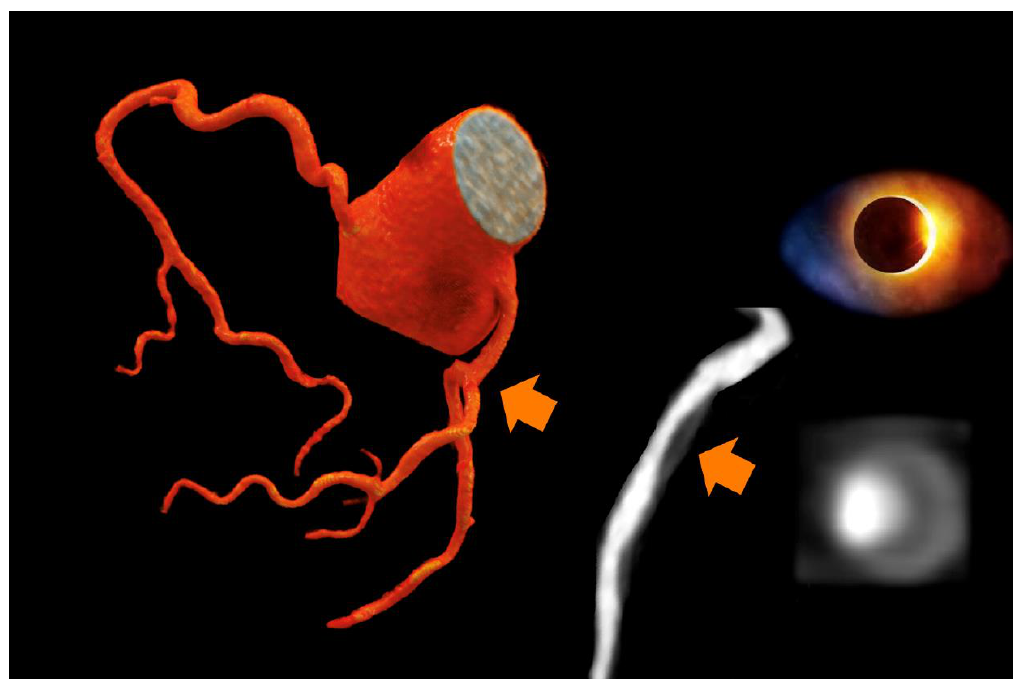
High-risk plaques by CTA were less frequently found in the vitamin D group as compared to controls ( p = 0.012). The high-risk plaque criteria spotty calcification and napkin ring sign were found slightly more often in controls, but prevalence was very low. Figure 2 shows a patient with a high-risk plaque in the control group, while Figure 3 shows a dense mixed plaque and multiple calcified plaques in a patient taking vitamin D as supplementation.